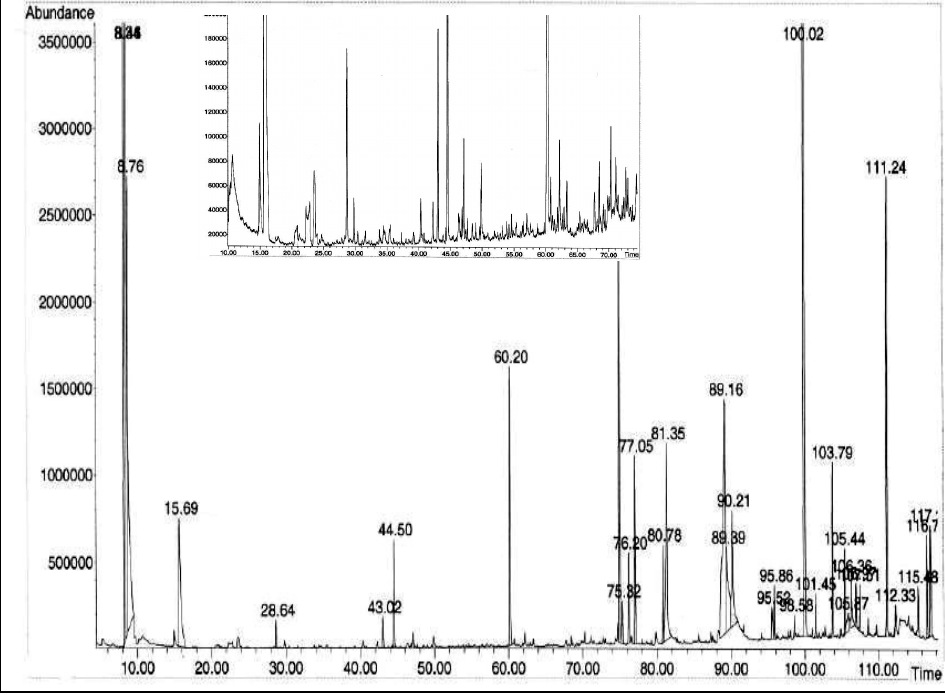
Figure 1. Gas chromatogram of volatile components of Sisymbrium